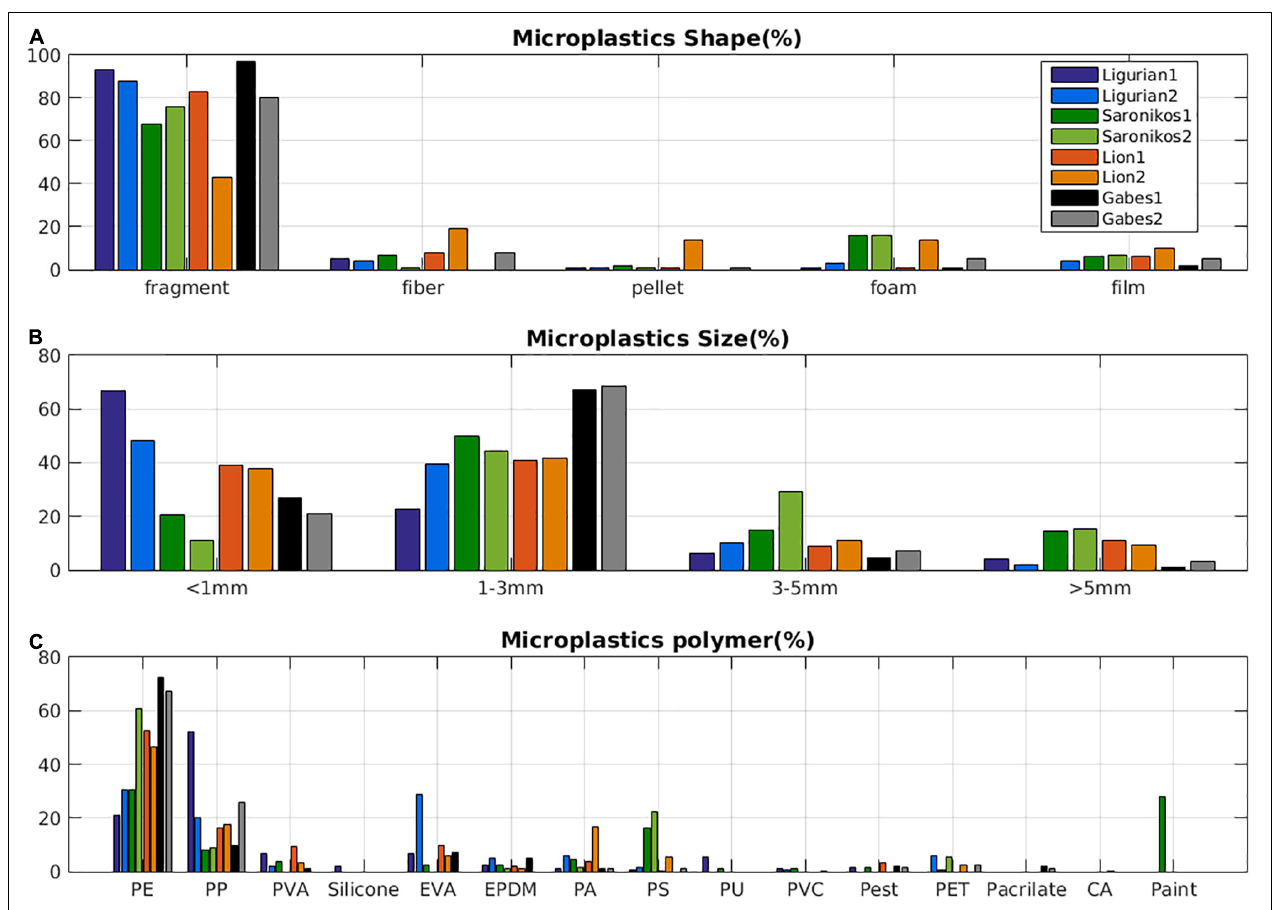
FIGURE 12 | Percentage distribution (mean values) of microplastics (MPs) collected in the CLAIM Key study areas (Saronikos Gulf, Ligurian Sea, Gulf of Lion, and Gabes Gulf) during both campaigns, according to (A) different shape (microplastic shape %), (B) size (microplastic size %), and (C) polymer characterization through ATR FT-IR analysis (microplastics polymer %). polyethylene (PE), polypropylene (PP), polyvinyl alcohol (PVA), polyurethane (PU), ethylene vinyl acetate (EVA), ethylene propylene diene monomer (EPDM), polyamide (PA), polystyrene (PS), polyester (pestere), polyethylene terephthalate (PET), polyvinyl chloride (PVC), cellulose acetate (CA), and polyacrylic rubber (polyacr